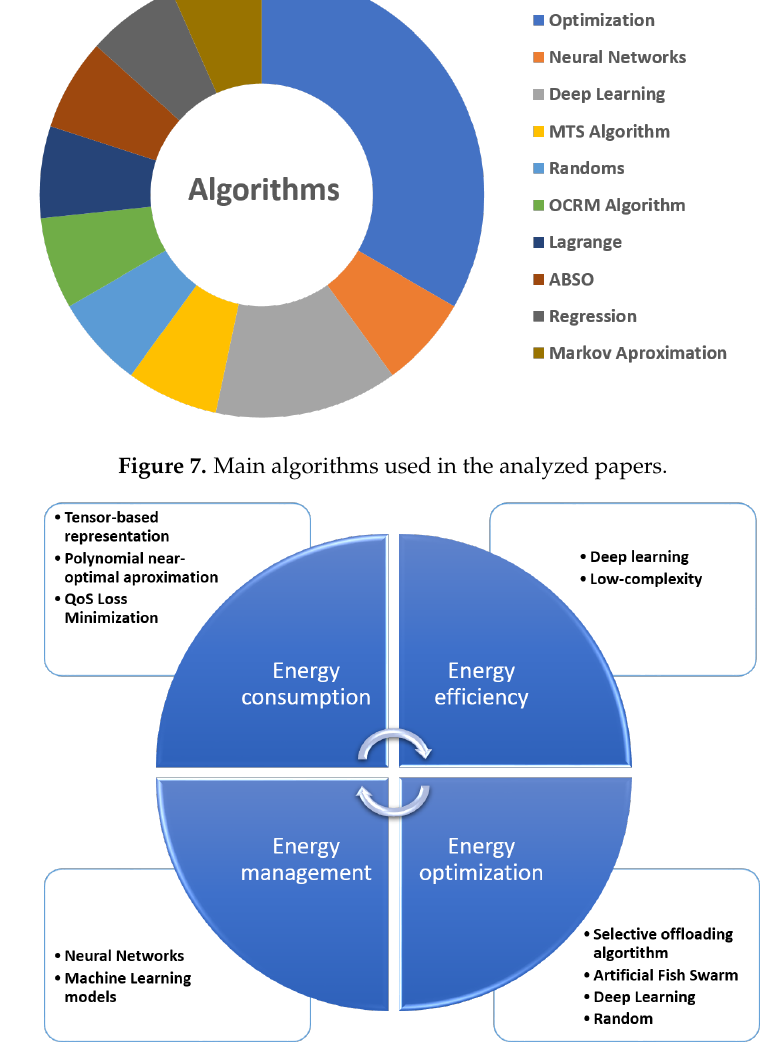
Figure 8. Algorithms for the identified energy